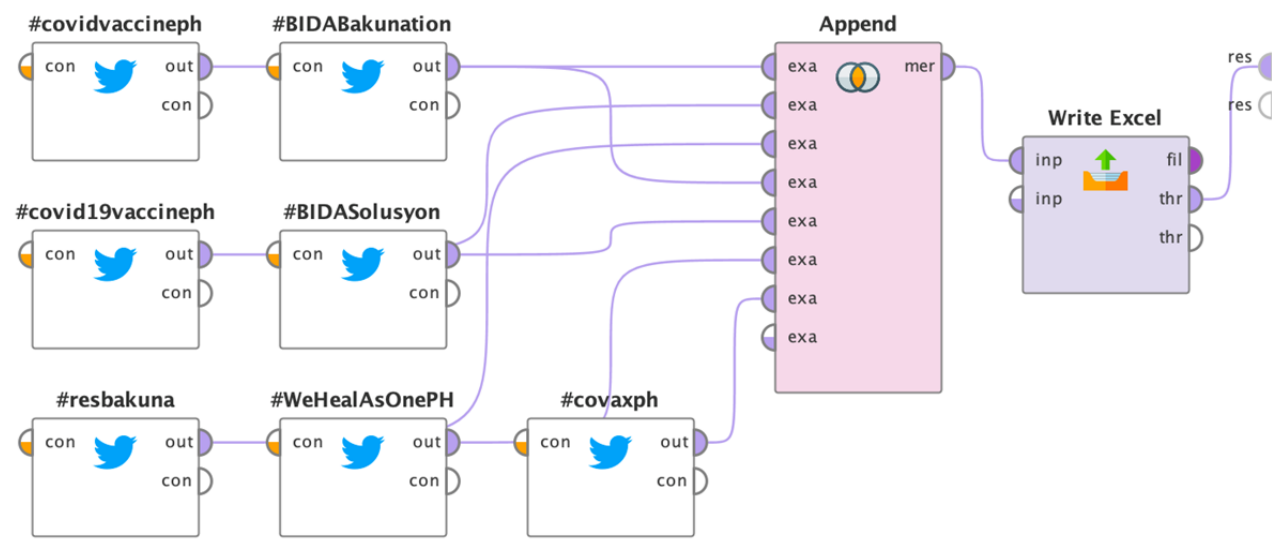
Figure 2. The RM Search Twitter operator with respective hashtags was used to collect tweets related to COVID-19, the Append operator was used to merge all the gathered tweets, and the Write Excel operator was used to store the data in an Excel file.